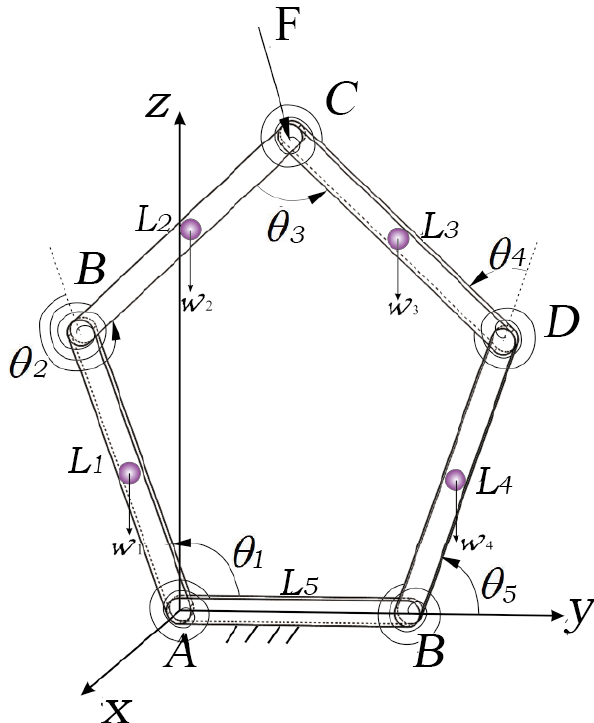
Figure 3. Kinetic model of the compliant five-bar